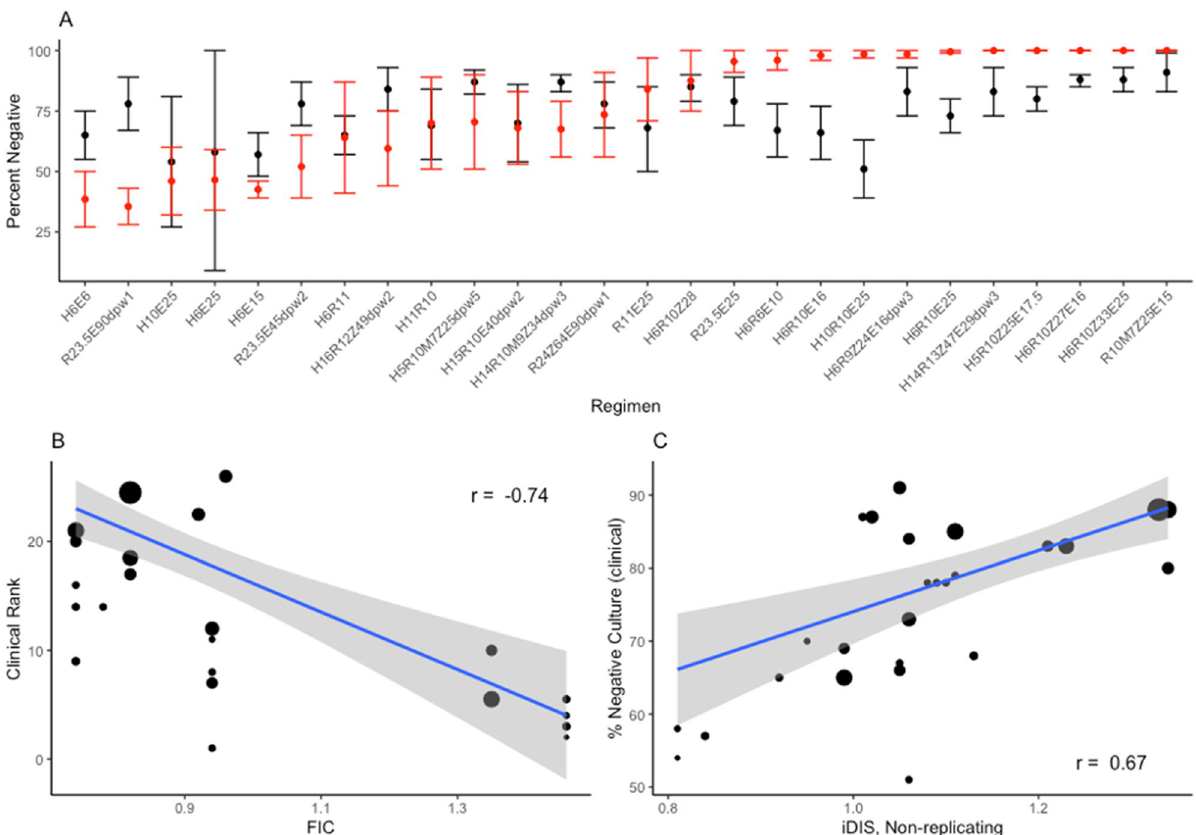
Figure 5. Comparison of treatment simulations with clinical trial results. The results for 26 different regimens compiled in Bonnet et al. 40 are compared to our treatment simulations. The clinical regimen efficacy metric used is solid culture conversion following 8 weeks of therapy. We compare the confidence intervals (black) to the percent of simulated granulomas that sterilized (lower red bar) or had fewer than 10 CFU after 8 weeks of therapy (upper red bar, red dot average of error bars) for all 26 regimens ( A ). Regimens are abbreviated by the single antibiotic abbreviation, followed by the dose in mg/kg for that antibiotic, with the doses per week (dpw) listed at the end of the regimen abbreviation. FIC is negatively correlated with clinical rank with a weighted correlation of − 0.74 ( B ), and iDIS is positively correlated with clinical rank with a weighted correlation of 0.67 ( C ). Each dot represents an individual regimen, its size is linearly scaled by the number of patients treated ( B , C ). Plots were made using the ggplot2 package in R 39